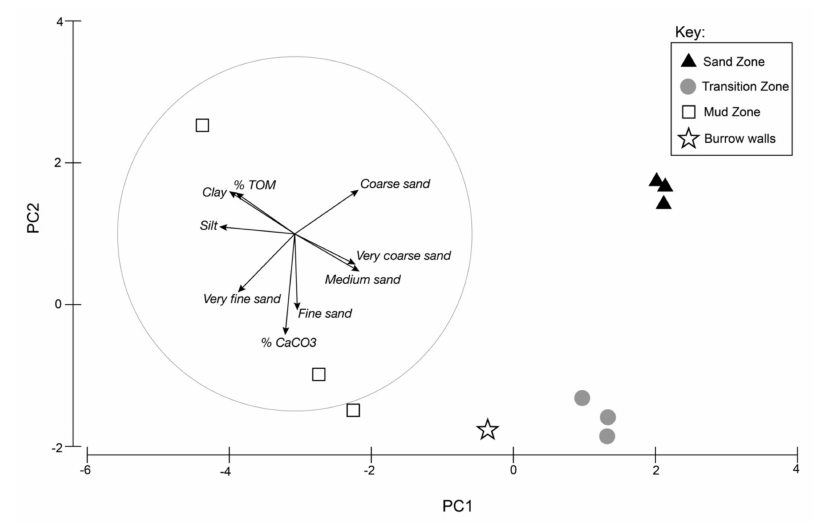
Figure 4. PCoA plot showing the sediment characteristics (vectors) for the three sampled sediment zones and for the burrow walls (symbols) in the autumn sampling. The first (PC1) and second (PC2) axes explain 55.5% and 30.0% of the total variation, respectively.